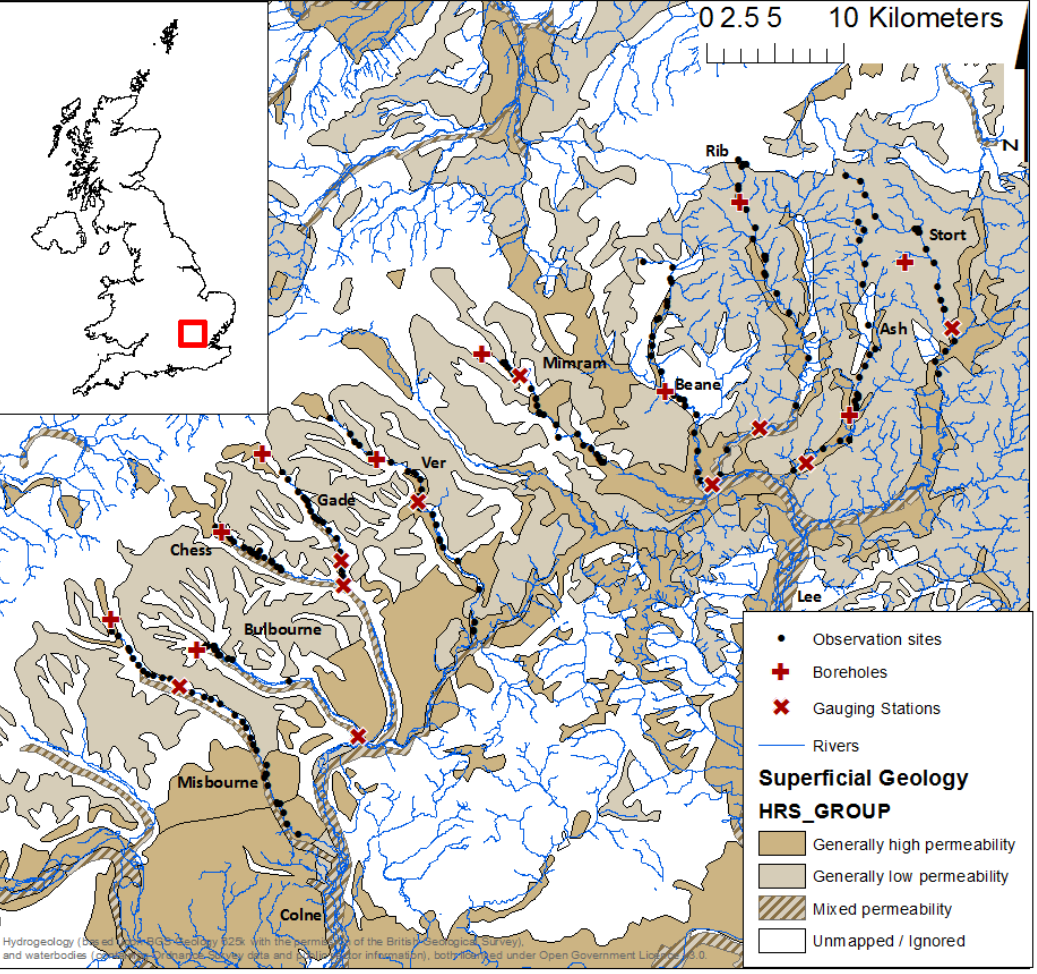
Figure 1. Location of the hydrological state observation sites, river flow gauging stations and groundwater boreholes in the Colne (Misbourne, Chess, Bulbourne, Gade and Ver) and Lee (Mimram, Beane, Rib, Ash and Stort) catchments, with underlying superficial geology types.